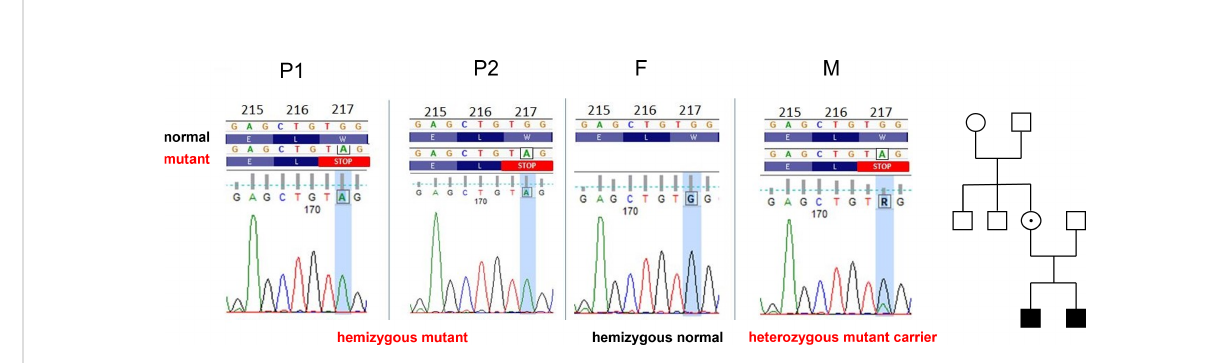
FIGURE 3 Identical MSN gene variants in P1 and P2: c.650G>A p.Trp217Ter, W217X (sixth exon). The father (F), maternal grandmother, and uncles carry wild-type alleles. The mother (M) is heterozygote. Family tree: white, wild-type; dotted, heterozygote, black, hemizygote.